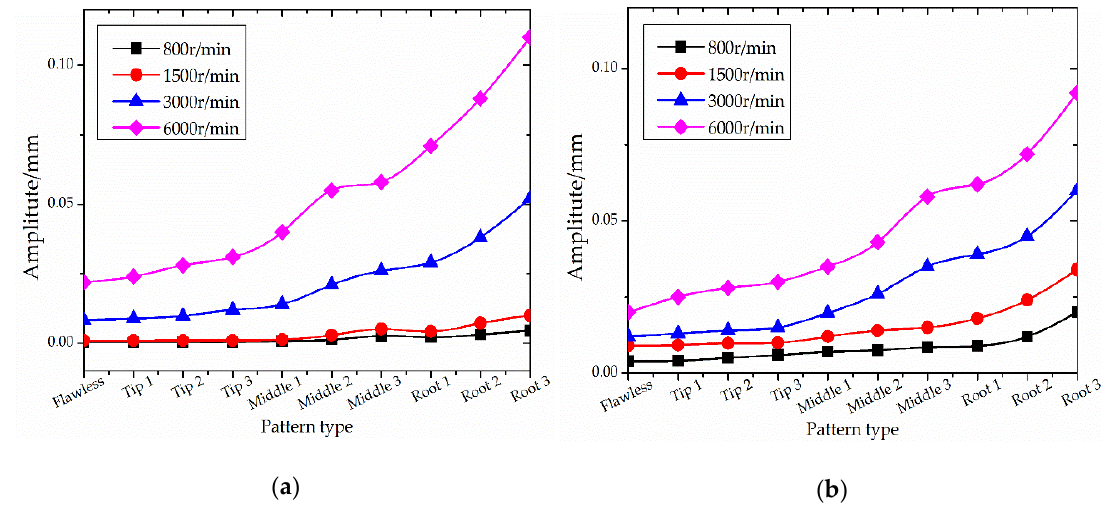
Figure 6. The relationship between blade states and deviation/tip clearance. ( a ) Deviation of blade dynamic balance; ( b ) tip clearances.